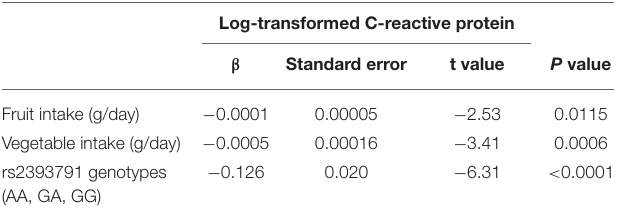
TABLE 3 | General linear model examining the association between fruit and vegetable intake and HNF1A rs2393791 with log-transformed C-reactive protein. Log-transformed C-reactive